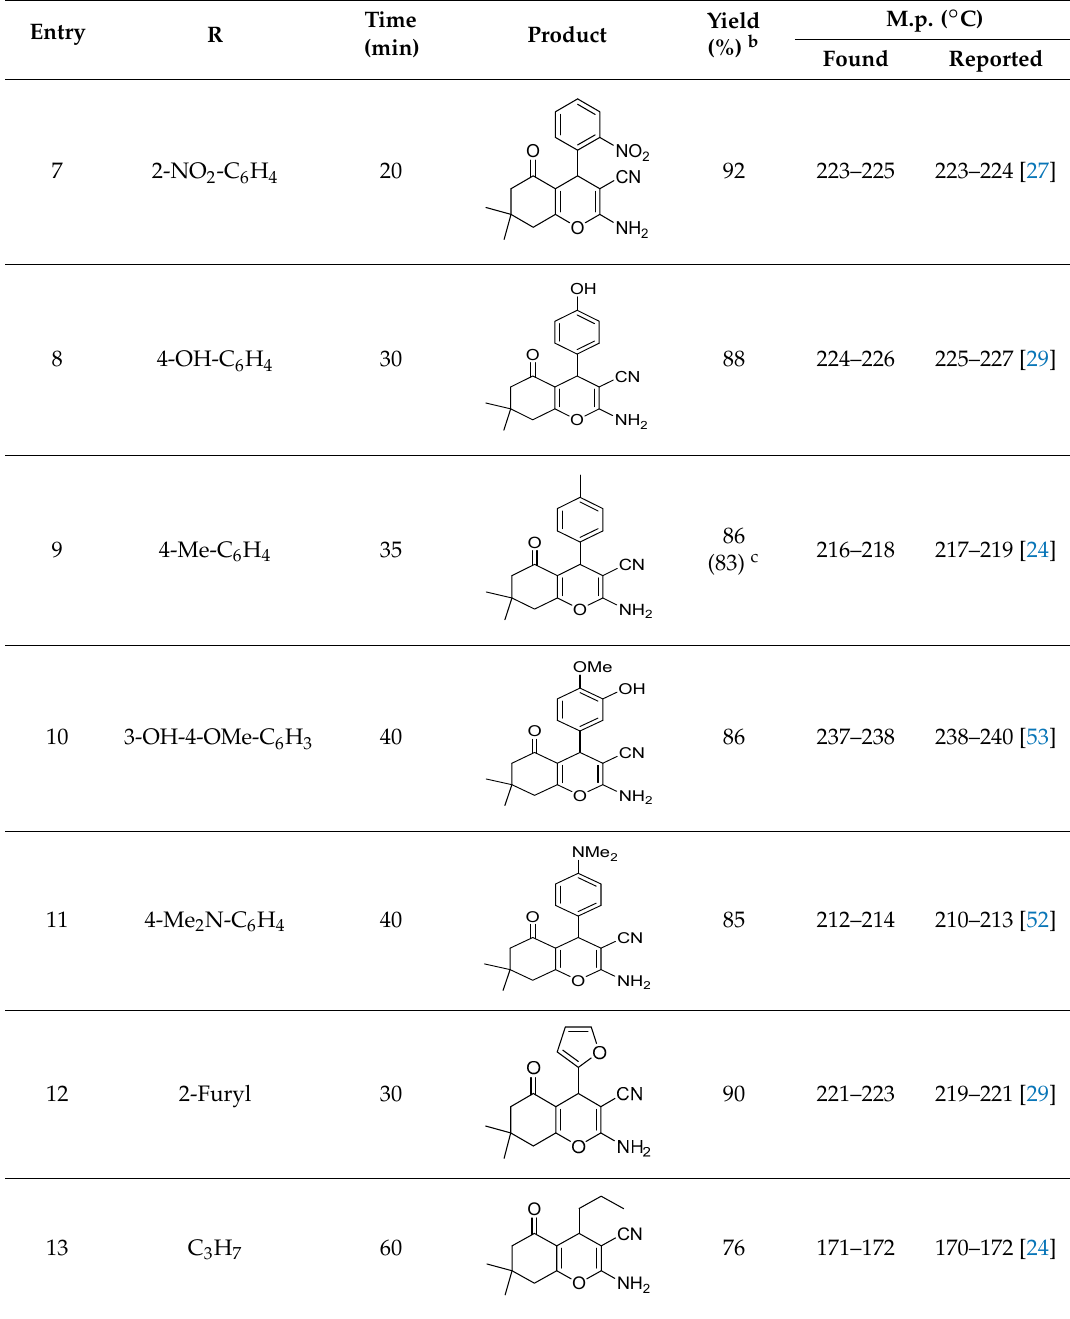
Table 5. Comparison of different catalysts for the one ‐ pot three ‐ component reaction of 4 ‐ chlorobenzaldehyde, malononitrile and dimedone.